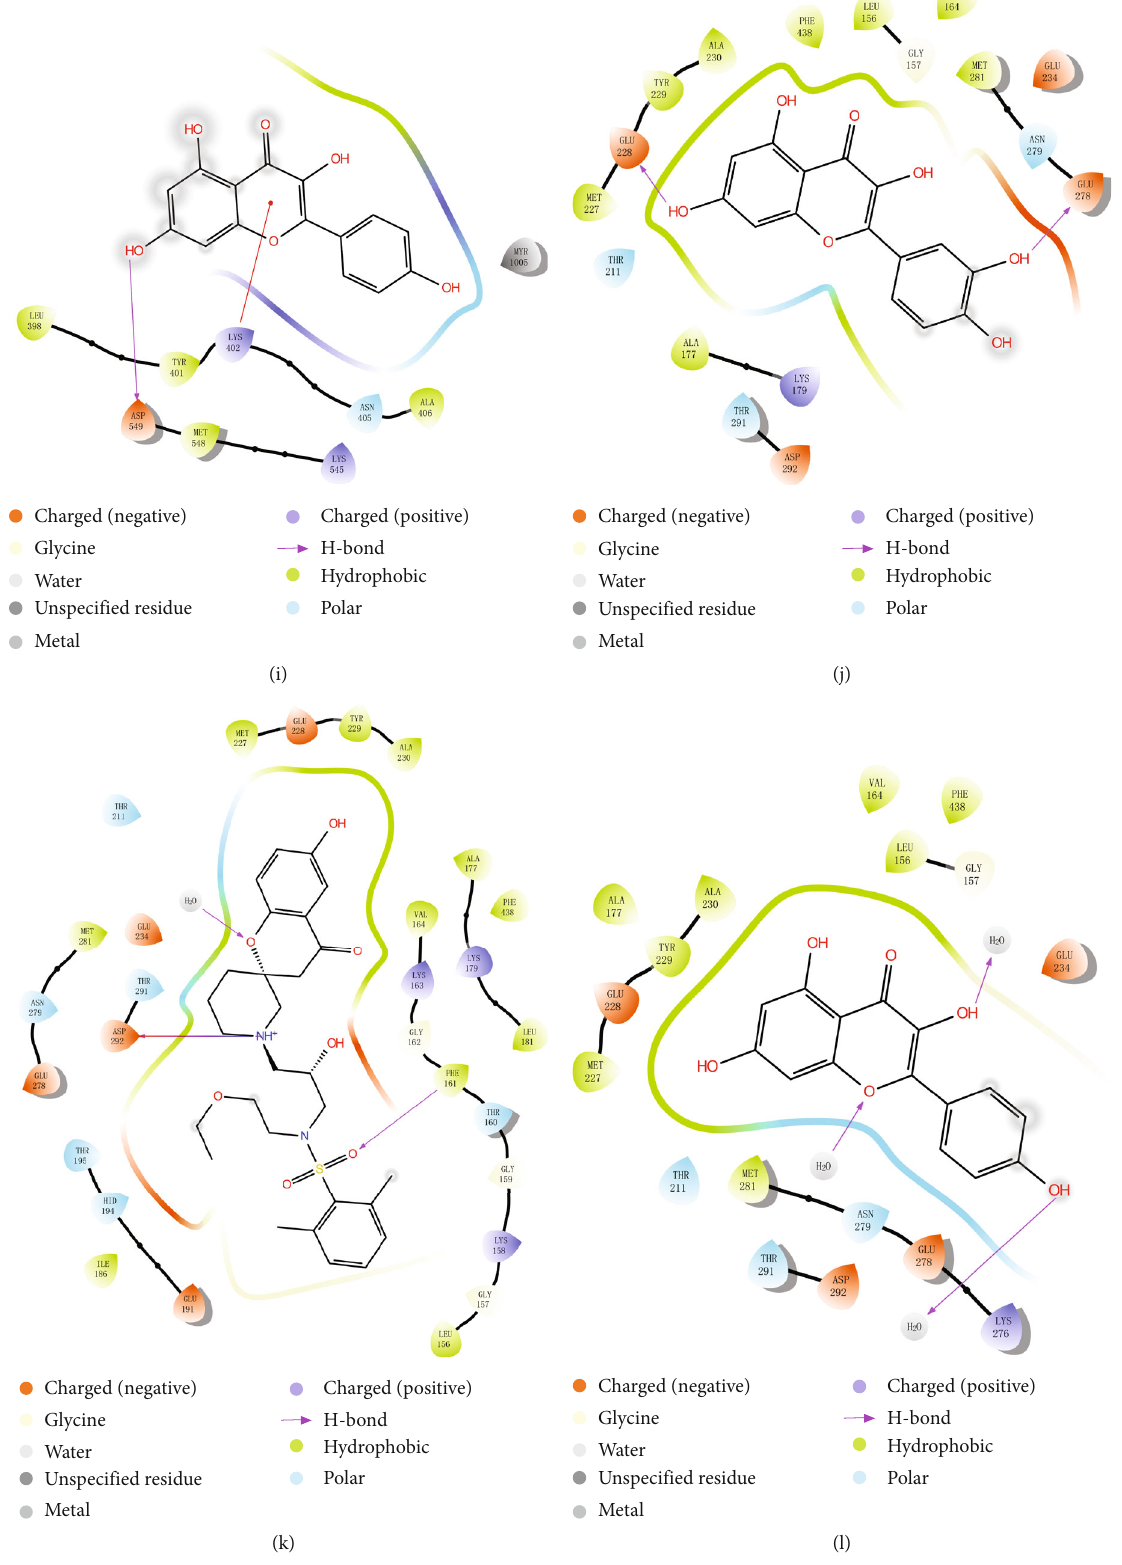
Figure 7: 2 D structure of 12 docking results: (a) IL6 with quercetin; (b) IL6 with luteolin; (c) IL6 with kaempferol; (d) INS with quercetin; (e) INS with luteolin; (f) INS with kaempferol; (g) ALB with quercetin; (h) ALB with luteolin; (i) ALB with kaempferol; (j) AKT1 with quercetin; (k) AKT1 with luteolin; (l) AKT1 with